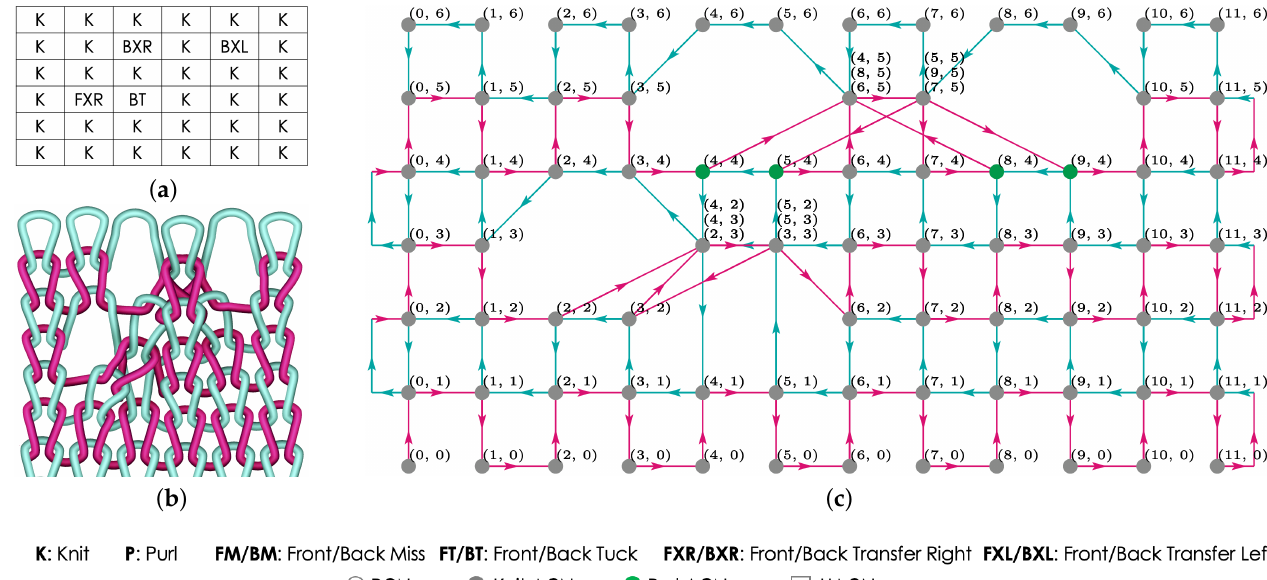
Figure 11. Stitch pattern with a combination of Knit, Front and Back Transfer, and Back Tuck